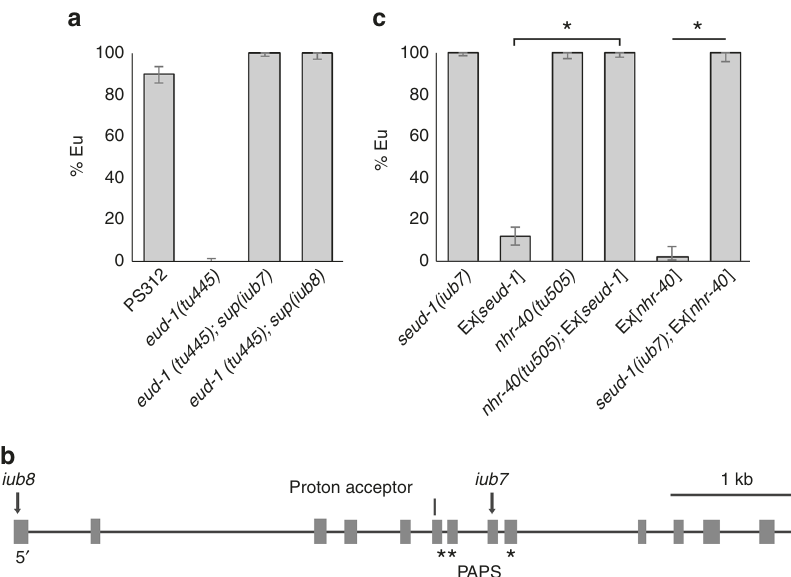
Fig. 2 Mutants, gene structure, and epistasis of the plasticity regulator seud-1 . a In contrast to the wild-type and eud-1 phenotypes, mutants iub7 and iub8 are completely penetrant for the suppressor-of-Eud (and all-eurystomatous) phenotype. b Mutants uncovered were the null alleles iub7 and iub8 , both of which lack an incomplete sulfotransferase domain (catalytic proton acceptor + PAPS sulfate donor). c Mutant rescue of seud-1 mutants with a transgenic construct, Ex[ seud-1 ], indicates the dosage-dependent activity of this gene, whose function is reciprocally necessary with nhr-40 for the polyphenism switch. Phenotype is the proportion of eurystomatous (Eu) individuals produced per clone. Scale bar, 20 µ m. % Eu, proportion of eurystomatous nematodes. * P < 0.0001 ( χ 2 -test). Whiskers represent a 95% con fi dence